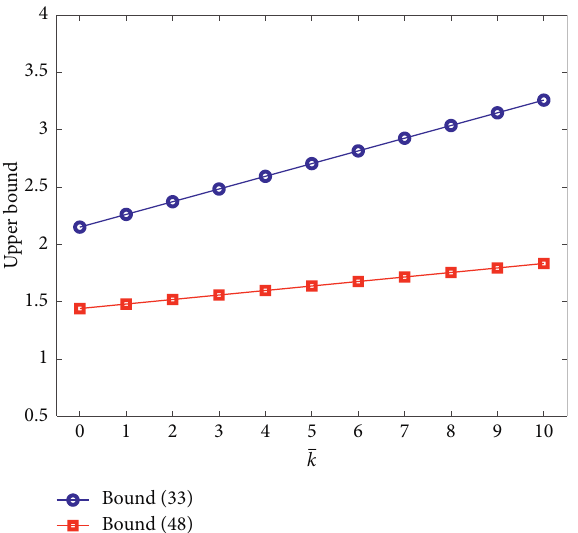
Figure 4: Bound (33) and bound (48) as a function of k .